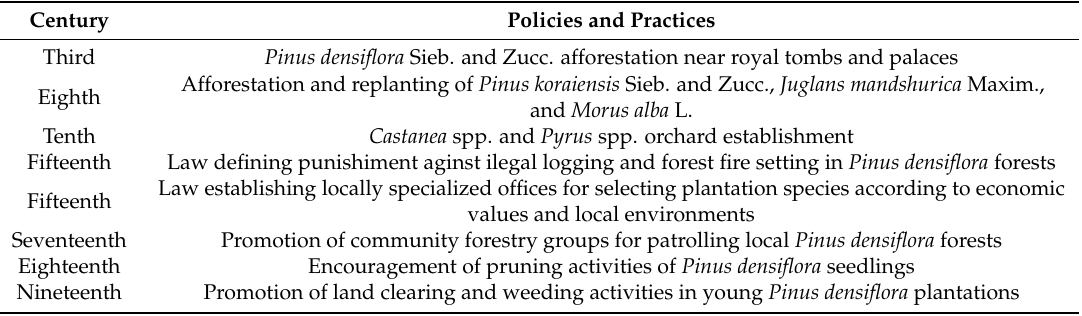
Table 1. Major forest management policies and practices of the ancient Korean kingdoms